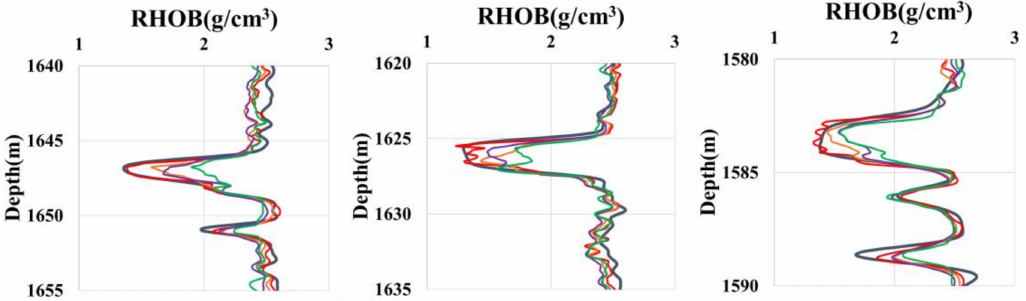
Figure 9. Local enlarged display of prediction results in Well